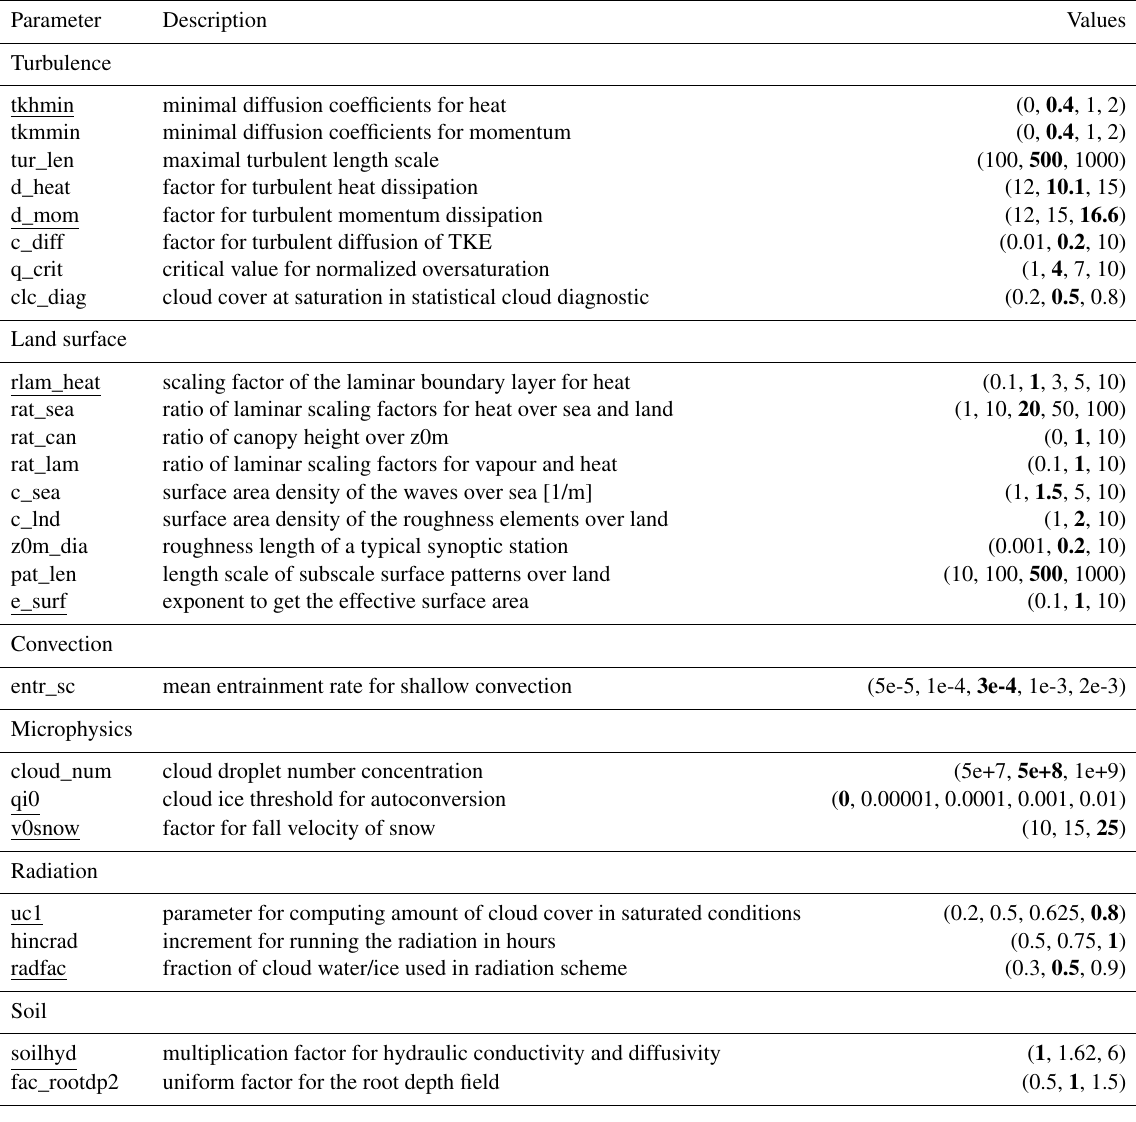
Table 2. List of model parameters and corresponding ranges of investigated input values. The parameter values of the default model config- uration are reported in bold. The finally selected COSMO-CLM most-sensitive parameters for the region are underlined. Parameter Description